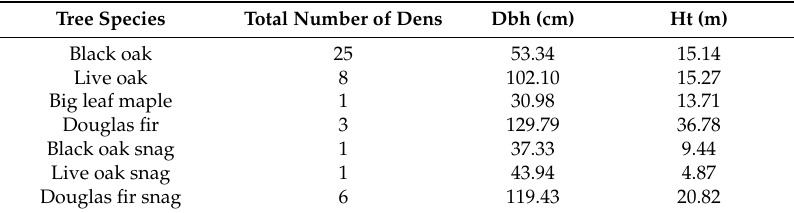
Table 6. Mean diameter at breast height (dbh) and height of fisher den trees and snags in the study area